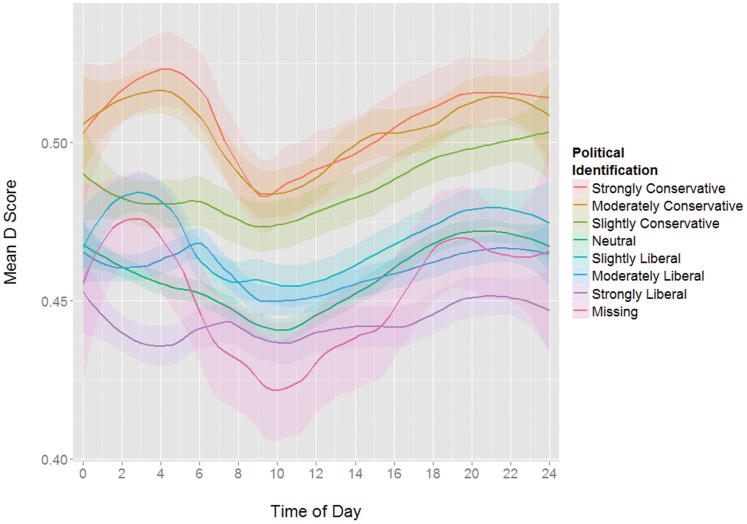
Mean D scores by time of day grouped by political identification.